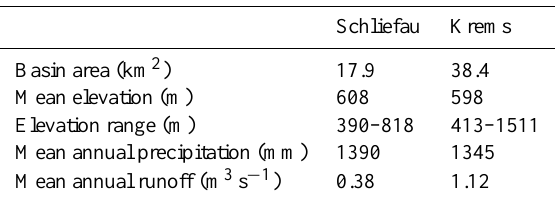
Figure 4. Schliefau and Krems catchments and location of mete- orological stations. Note that ground observation of rainfall is not part of the INCA stations network. Table 4. Characteristics of the study catchments (BMLFUW, 2007; BMLFUW,